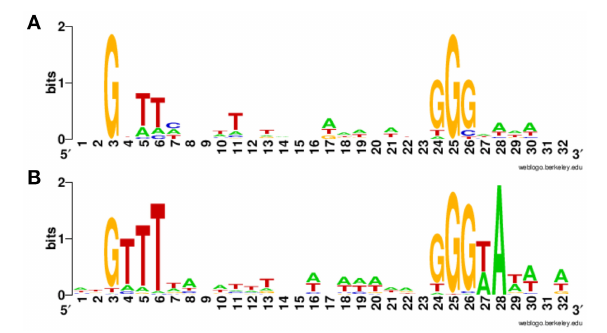
FIGURE 3 | Sequence logo for newly identified putative σ B -dependent promoters. (A) Sequence logo for the 18 σ B -dependent promoters associated with newly identified σ B -dependent genes. (B) Sequence logo for σ B -dependent promoters published in previous study (Oliver et al.,